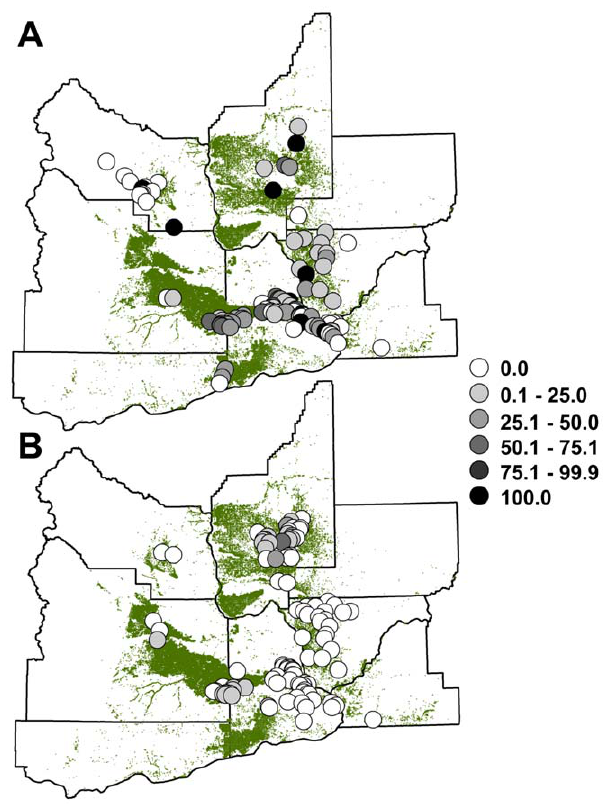
Figure 3. Prevalence of West Nile virus infection in mosquitoes. Proportion of mosquito pools that tested positive for West Nile virus (WNV) infection at each mosquito trap location in (A) 2009 and (B) 2010 across eight counties in Washington State. Each mosquito trapping location is indicated with a circle, with different levels of shading indicating a different class of values for the proportion of positive mosquito pools. Land covered by orchards in each year is shown in green.